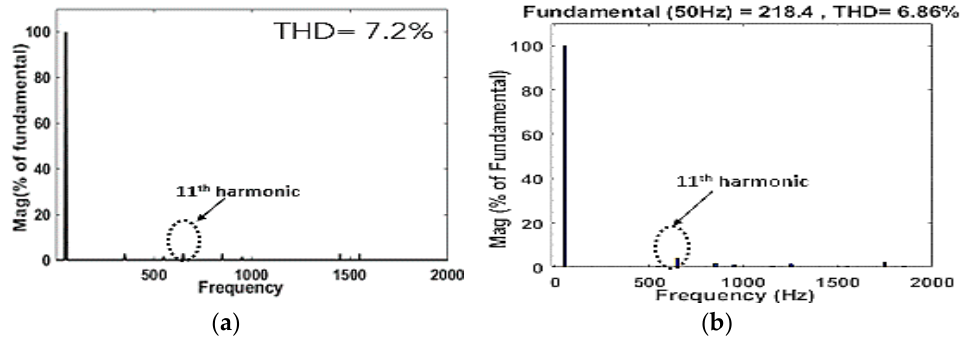
Figure 16. ( a ) Experimental THD of output voltage; ( b ) Simulated THD of output voltage.